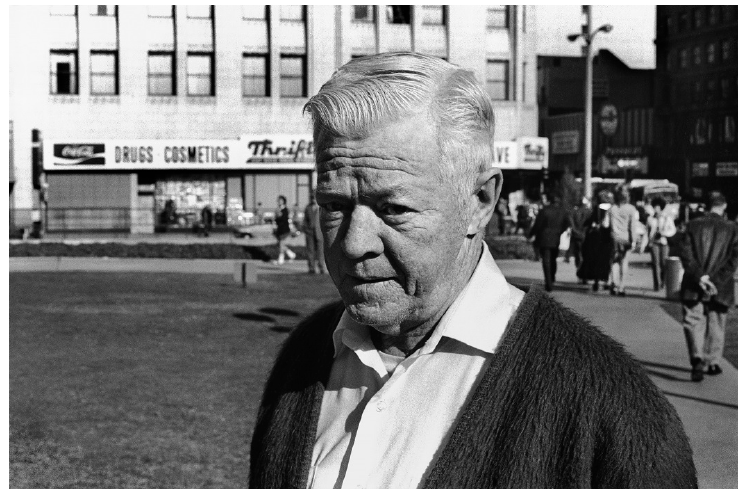
Figure 8. Anthony Hernandez, Los Angeles #6 (1971), © Anthony Hernandez.